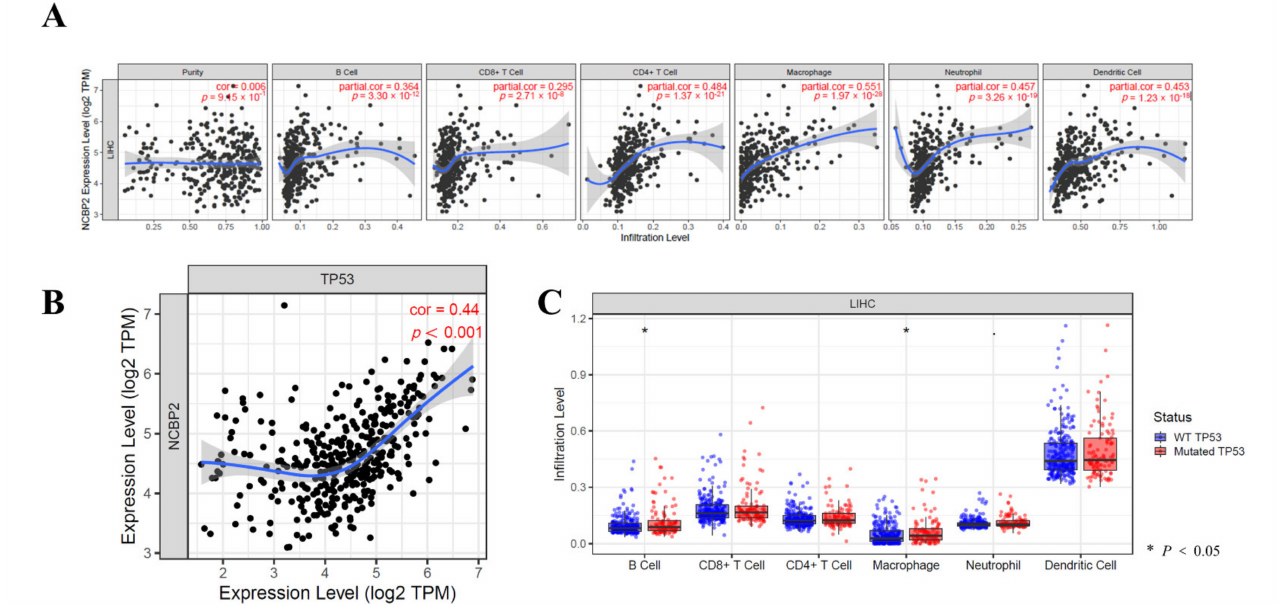
Figure 8. Correlation of NCBP2 expression and TP53 mutation with immune infiltration levels in LIHC. ( A ) Relationship of NCBP2 expression with immune infiltration. ( B ) Relationship of NCBP2 expression with TP53. ( C ) Correlation between TP53 mutation and immune